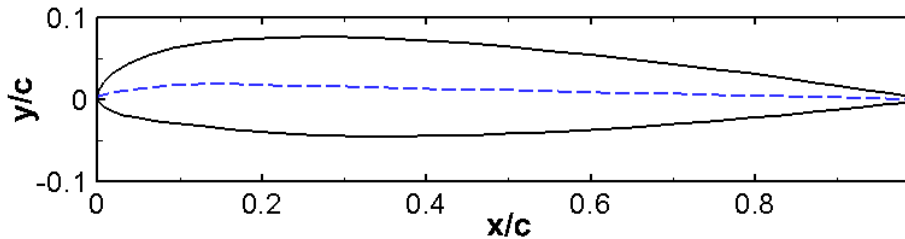
Figure 3. The NACA23012 airfoil section. Table 1. The specifications of the target propeller.